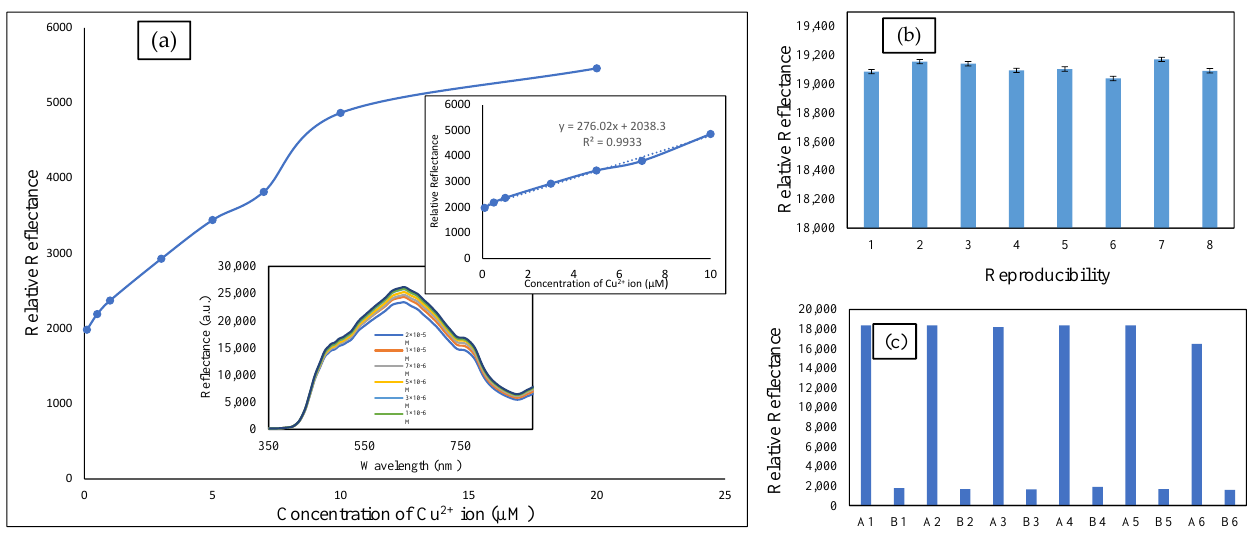
Figure 6. ( a ) Spectrum of the detection of Cu 2+ ion ranging from 1 × 10 − 7 M to 2 × 10 − 5 M; ( a ) (inset) linear response range of Cu 2+ ion detection from 1 × 10 − 7 M to 1 × 10 − 5 M; ( b ) reproducibility study of Cu 2+ ion sensor based on TL – SBA15 ( n = 8); and ( c ) reversibility of Cu 2+ ion sensor with 1 × 10 −5 M Cu 2+ ion solution (A1, A2, A3, A4, A5 and A6) and 0.1 M EDTA regeneration solution (B1, B2, B3, B4, B5, and B6).